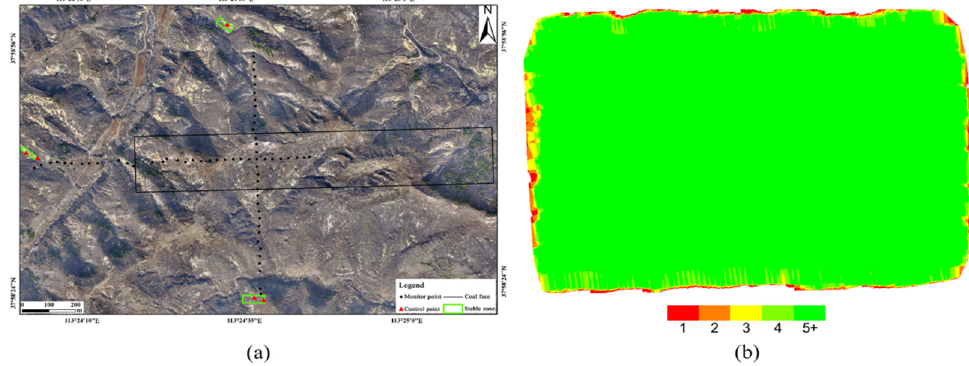
Figure 3. Selection of the stable region: ( a ) stable zone for collaborative registration; and ( b ) number of overlapping images computed for each pixel of the DOM.